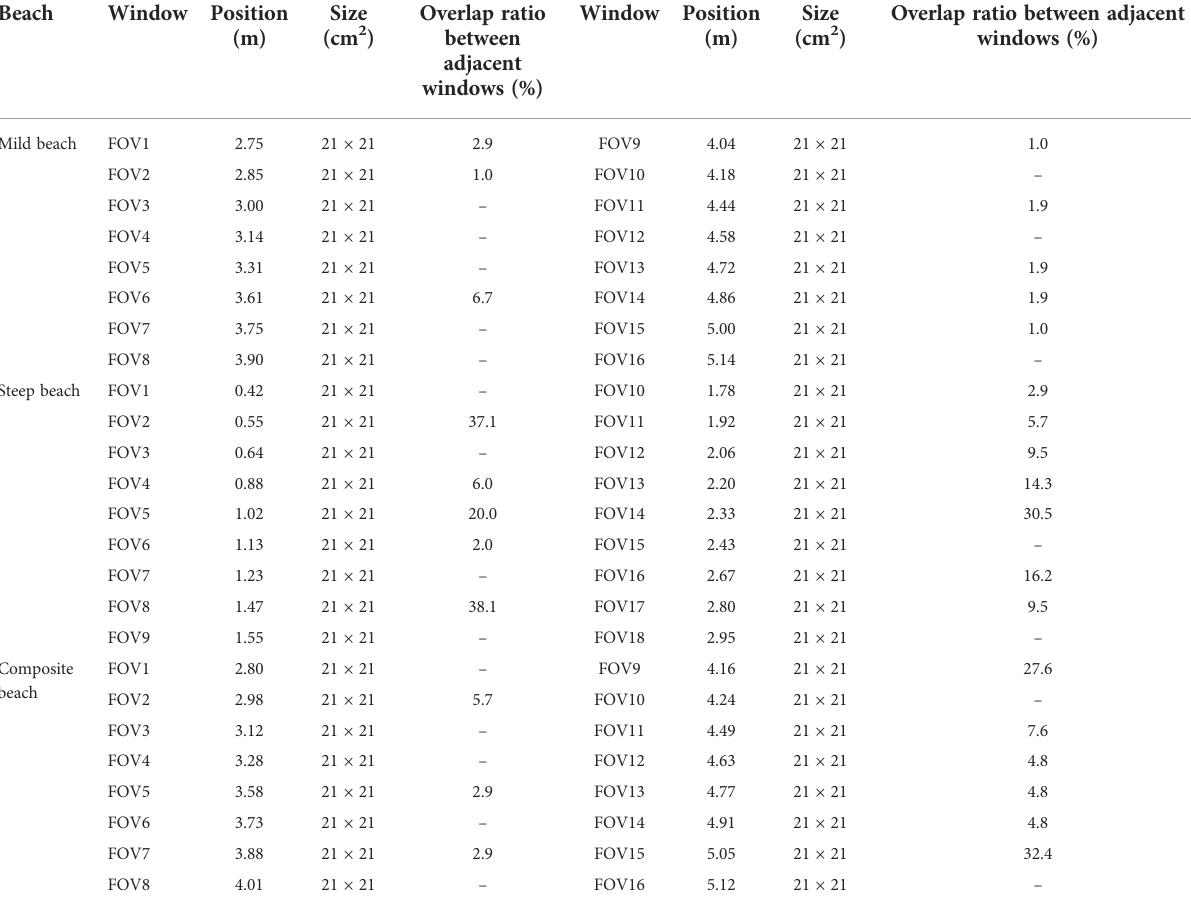
Window Position